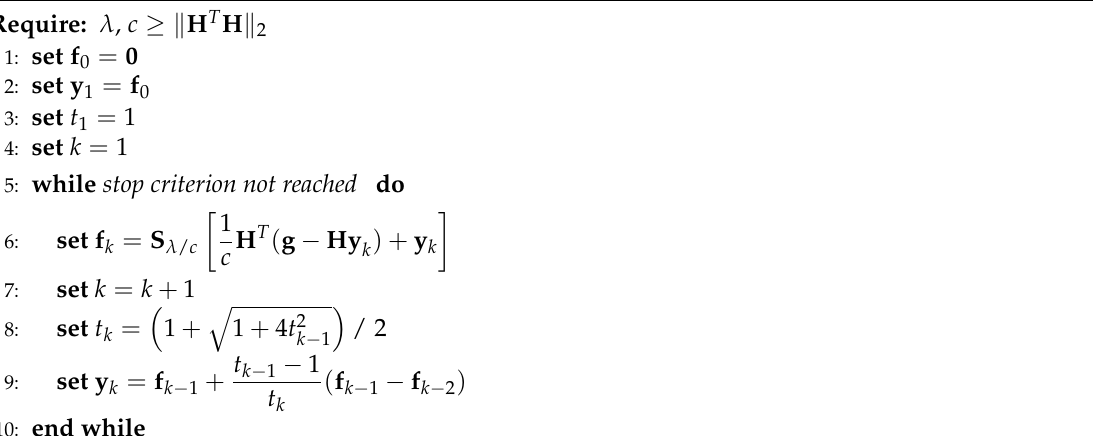
Algorithm 1 Fast Iterative Shrinkage-Thresholding Algorithm (FISTA)